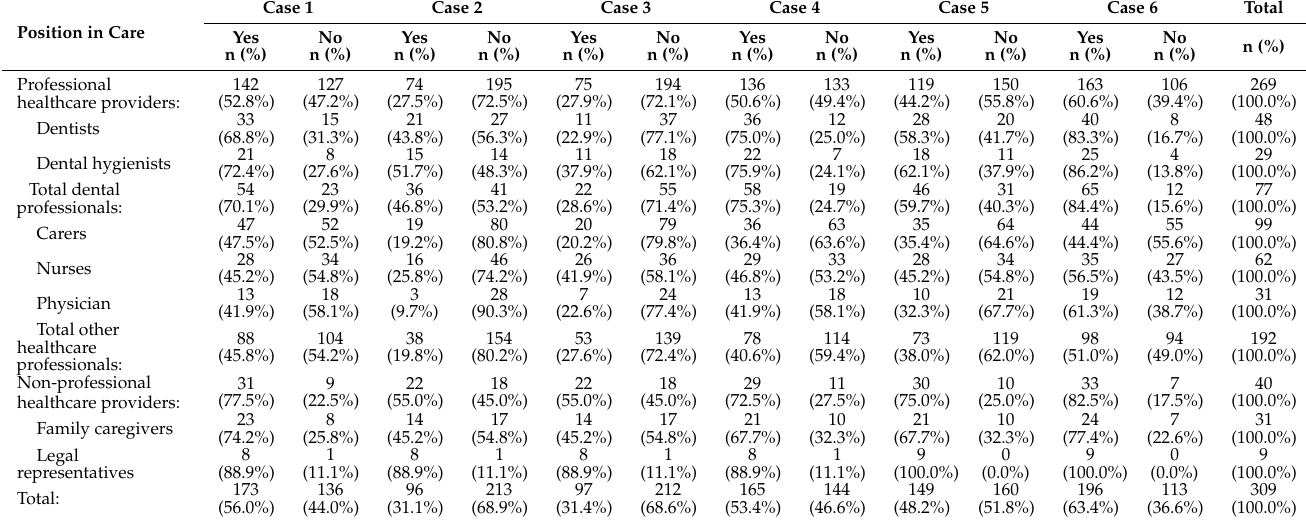
Table 3. Participants’ responses the willingness to provide involuntary oral care (Question 2) of Cases 1 to 6.